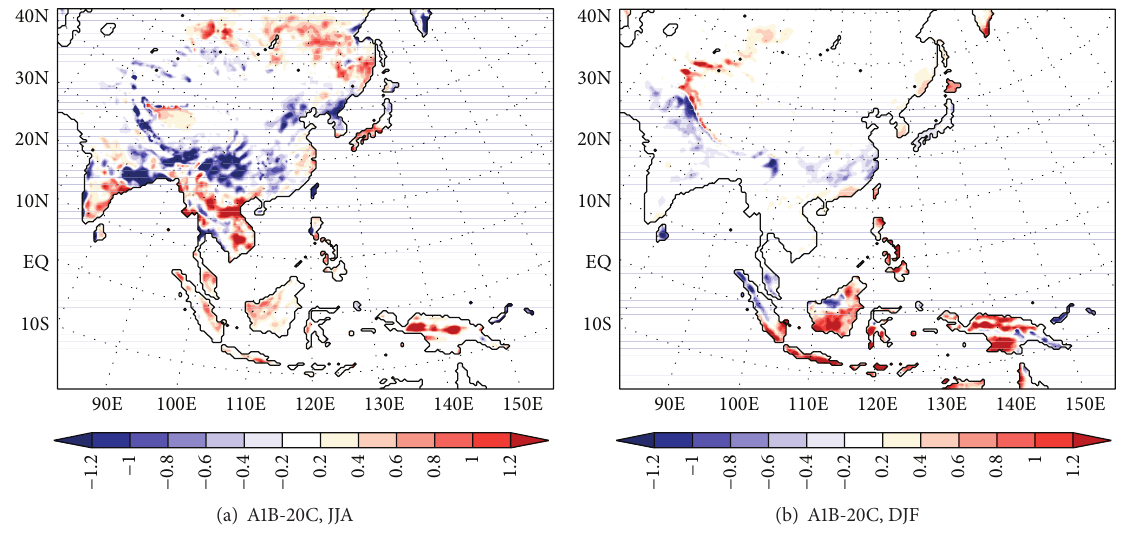
Figure 4: Differences of seasonally averaged runoff (mm d −1 ) of the A1B run from the 20C run for (a) JJA and (b)